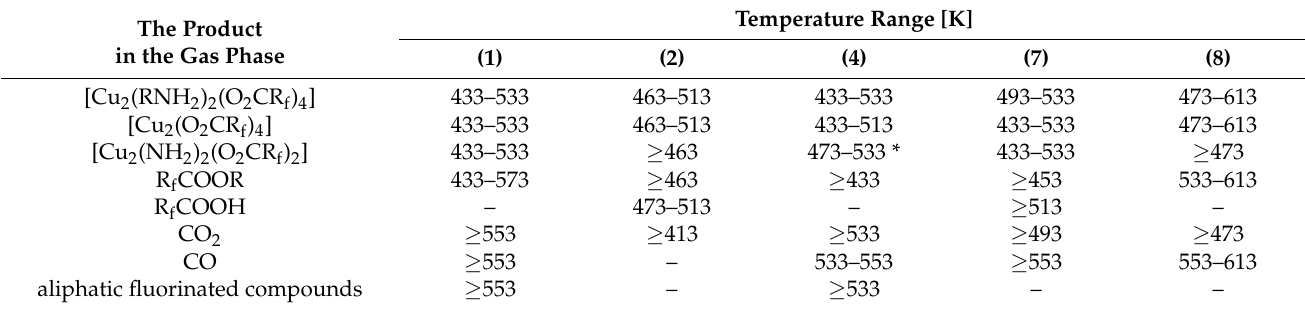
Table 5. Temperature ranges of occurrence of decomposition products in the gas phase for compounds ( 1 ), ( 2 ), ( 4 ), ( 7 ), and ( 8 ).